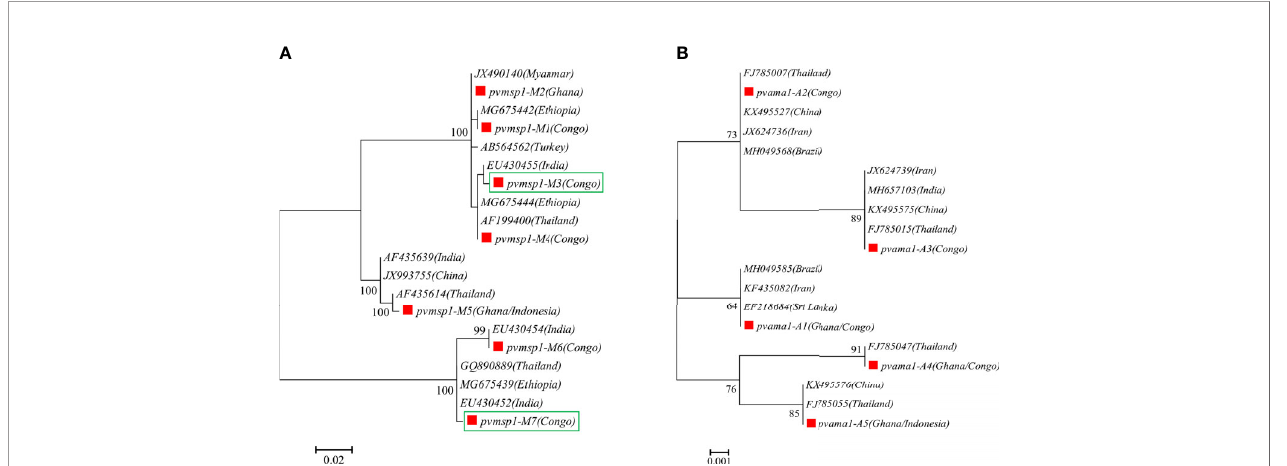
FIGURE 2 | Molecular phylogenetic analysis by the maximum likelihood method based on haplotypes determined by amplicon deep sequencing in P. vivax . (A) pvmsp1 phylogenetic tree for the seven haplotypes (M1 – M7) and 13 sequences retrieved from GenBank (AB564562, AF199400, AF435614, AF435639,